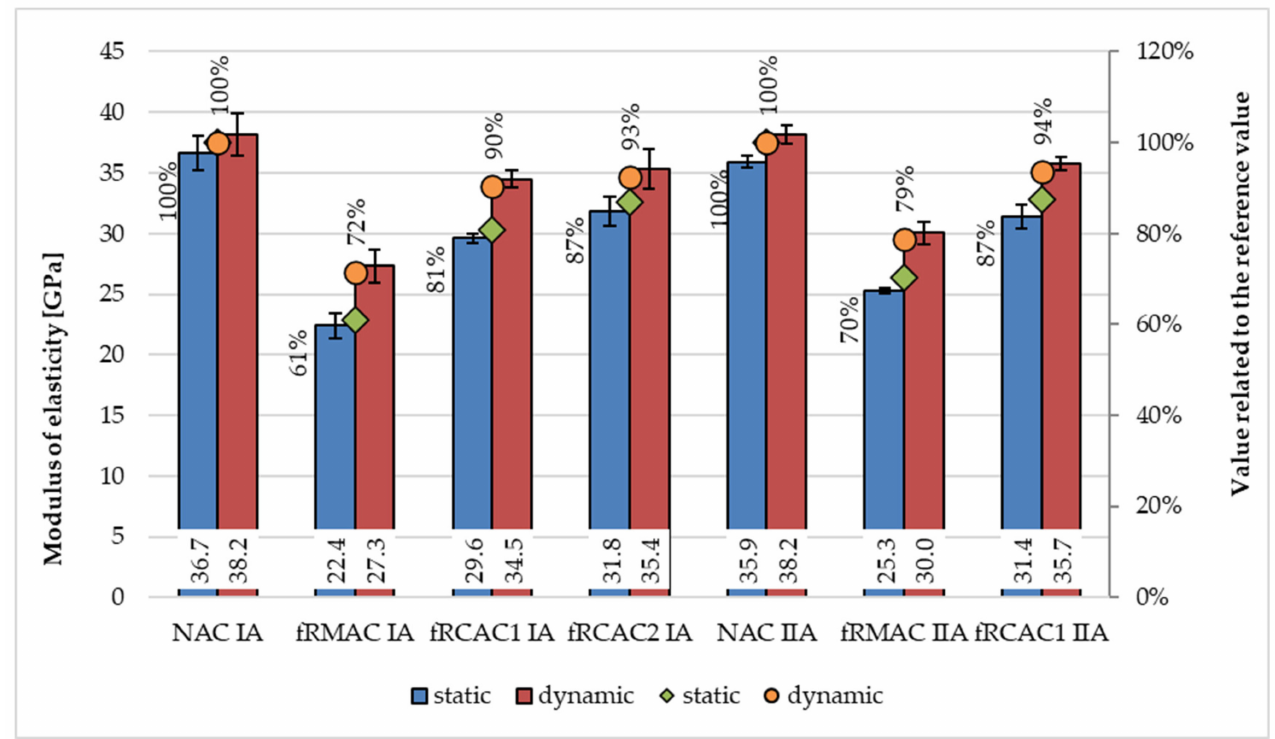
Figure 9. Comparison of static and dynamic moduli of elasticity at age 28 days for concrete mixtures prepared by the Czech team.